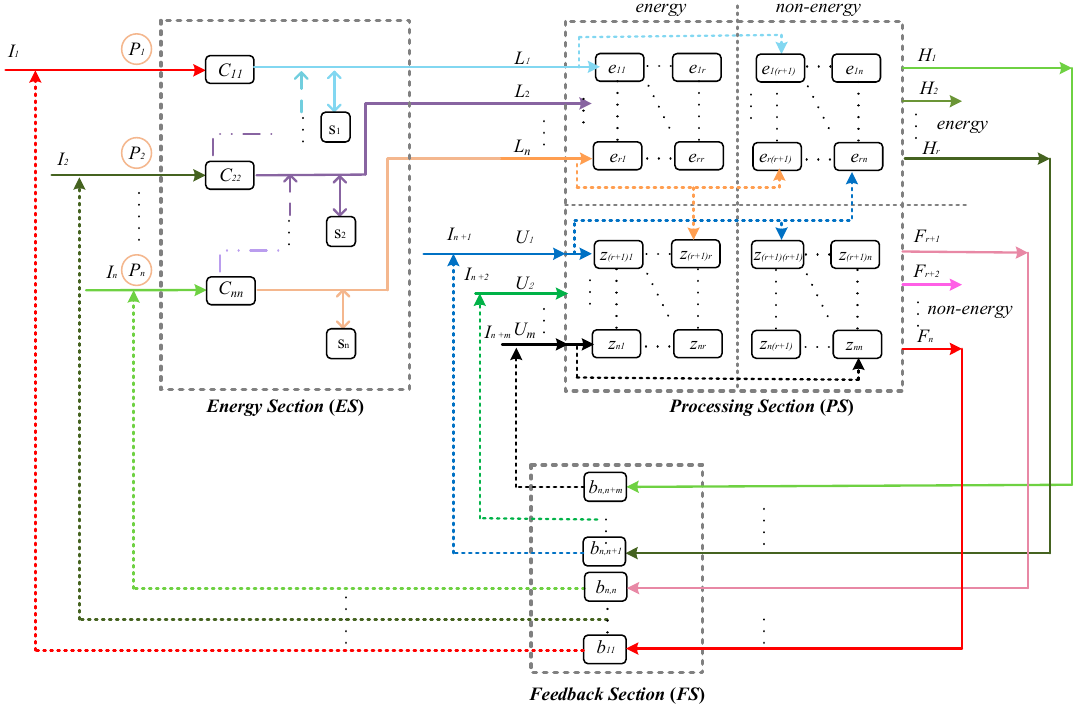
Figure 2. Illustration of Generalized Energy and Material Flow Model.